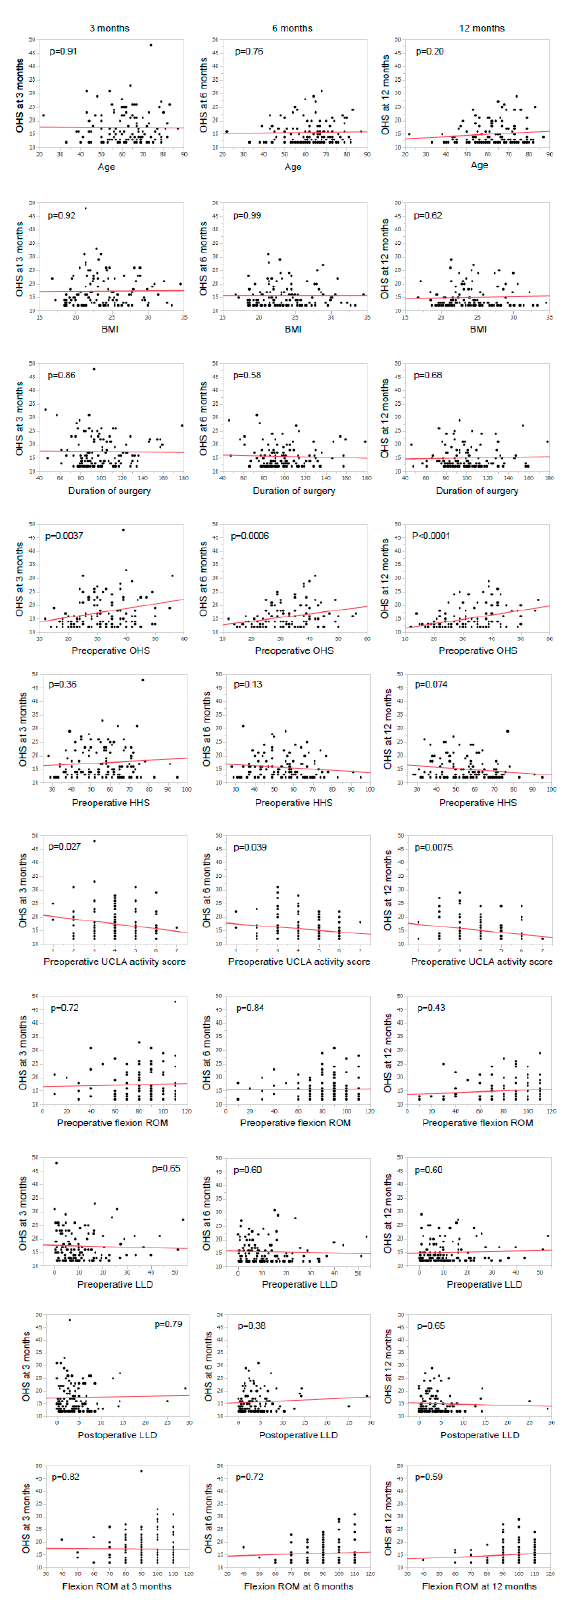
Figure 1. Univariate regression analysis of the relationships between each variable and the Oxford Hip Score (OHS) at 3, 6, 12 months after total hip arthroplasty. The solid lines indicate the regression lines. BMI: Body mass index; HHS: Harris Hip Score; ROM: Range of motion; LLD: Leg length discrepancy; UCLA: University of California Los Angeles.